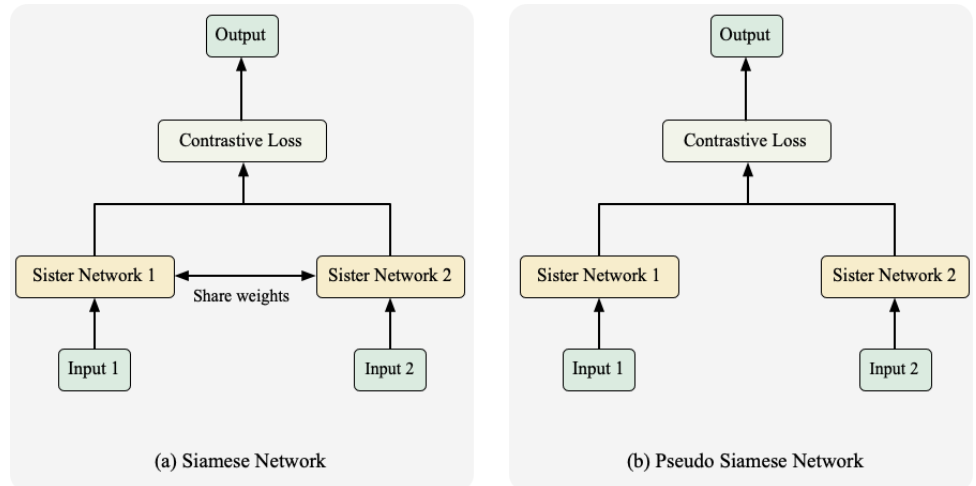
Figure 1. The architecture of the Siamese